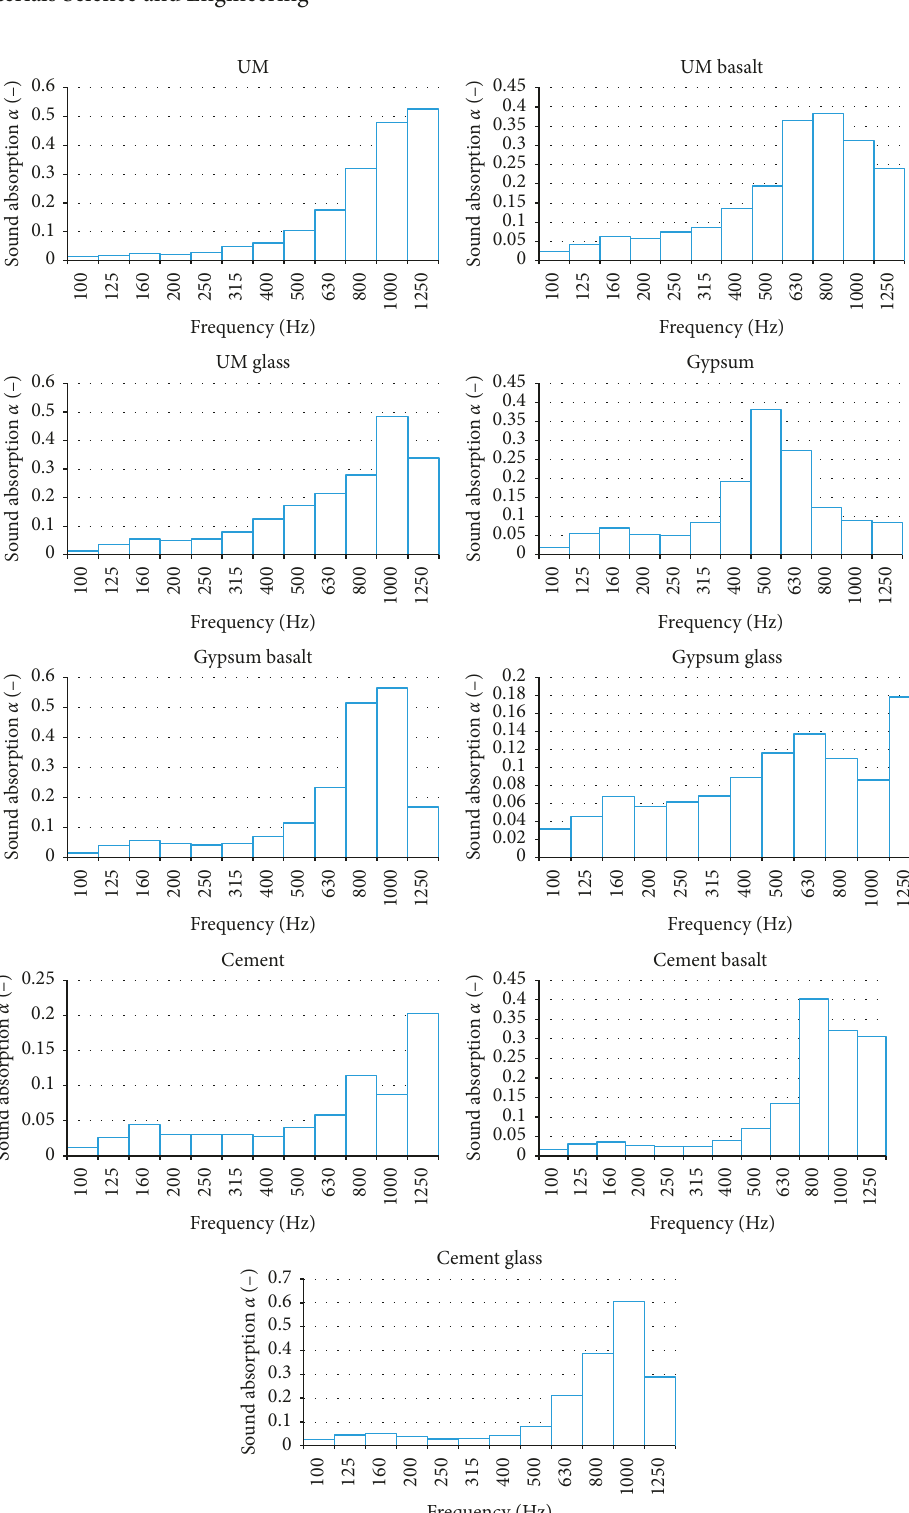
Figure 17: Comparison of the individual samples in the third-octave